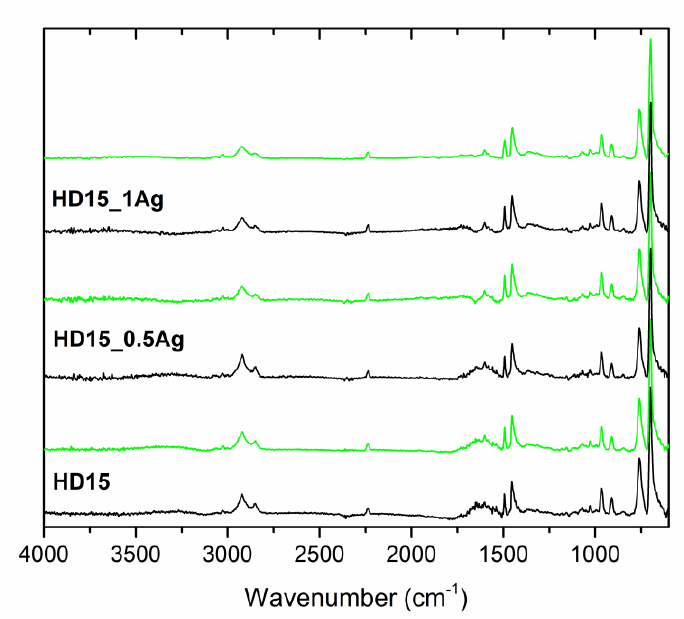
Figure 14. ATR-FTIR spectra of pure polymer (E205FC) and polymer containing 0.5 wt % and 1.0 wt % of silver nanoparticles AgNPs before incubation (black line) and after 24 months of incubation (light green line). Table 3. Band positions and their assignments for ATR-FTIR spectra of the pure polymers and